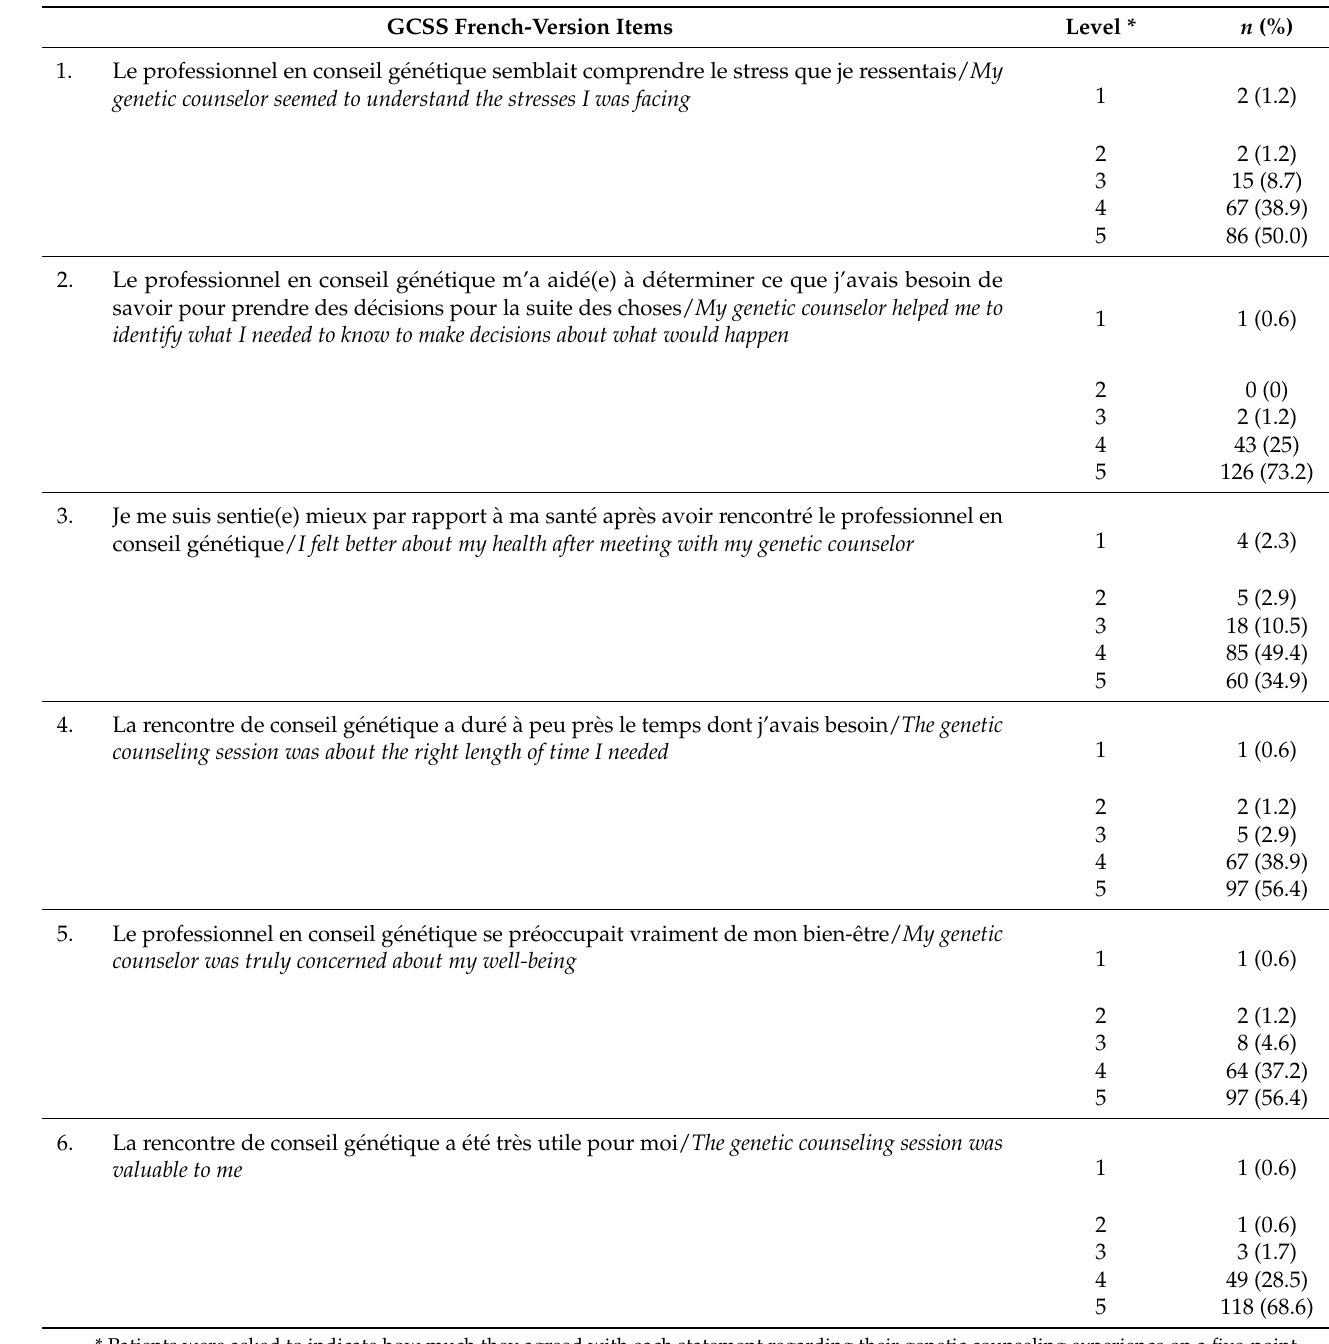
Table 3. Item-level responses from GCSS to assess the presence of floor and ceiling effects ( N =